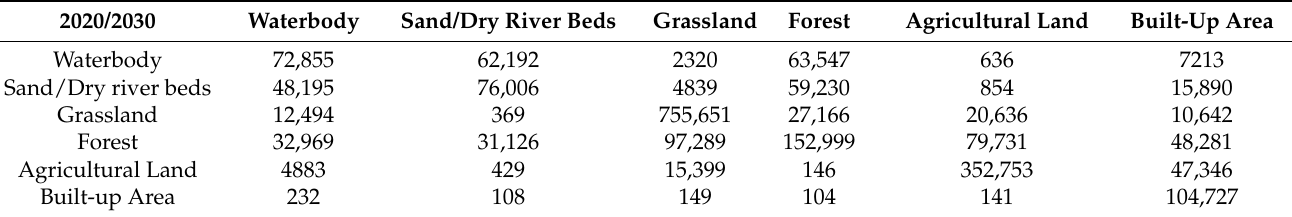
Table 7. Expected transition in 2030 by number of